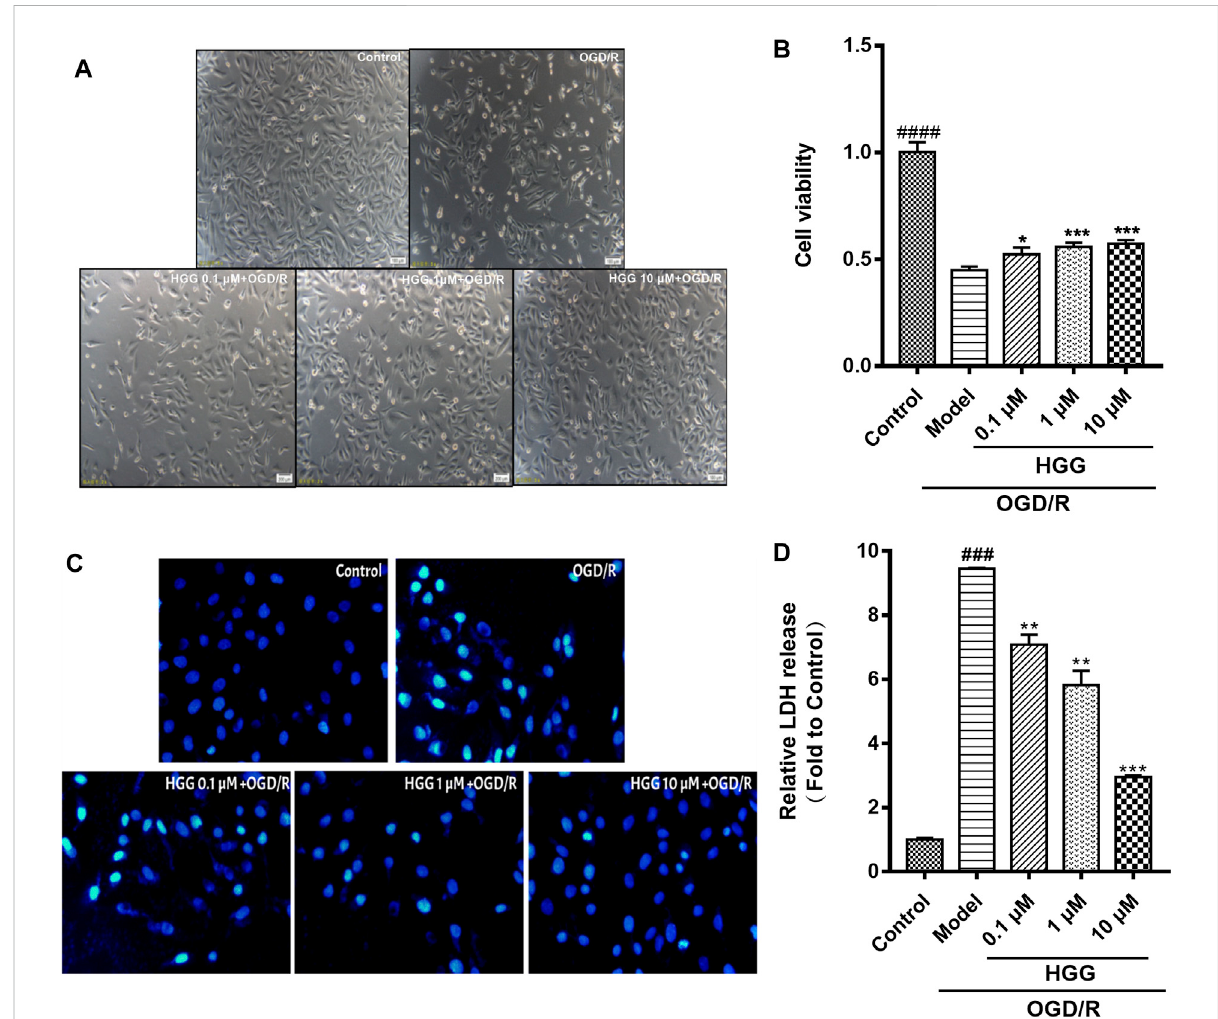
FIGURE 3 HGG signi fi cantly prevents OGD/R-induced damage on HUVECs in a dose-dependent manner. (A) Morphology of HUVECs cultured in normoxic, and in HGG-treated HUVECs after OGD/R; (B) Cell viability of HUVECs under OGD/R and treated with or without HGG; (C) The morphological features of cell apoptosis of OGD/R by Hoechest-33342 staining; (D) LDH release in HGG-treated HUVECs after OGD/R; All data are presentedasmeans±SDfromindependentexperimentsperformedintriplicate. ### p < 0.001, #### p < 0.0001vs.Control;* p < 0.05,** p < 0.01, *** p < 0.001 vs.